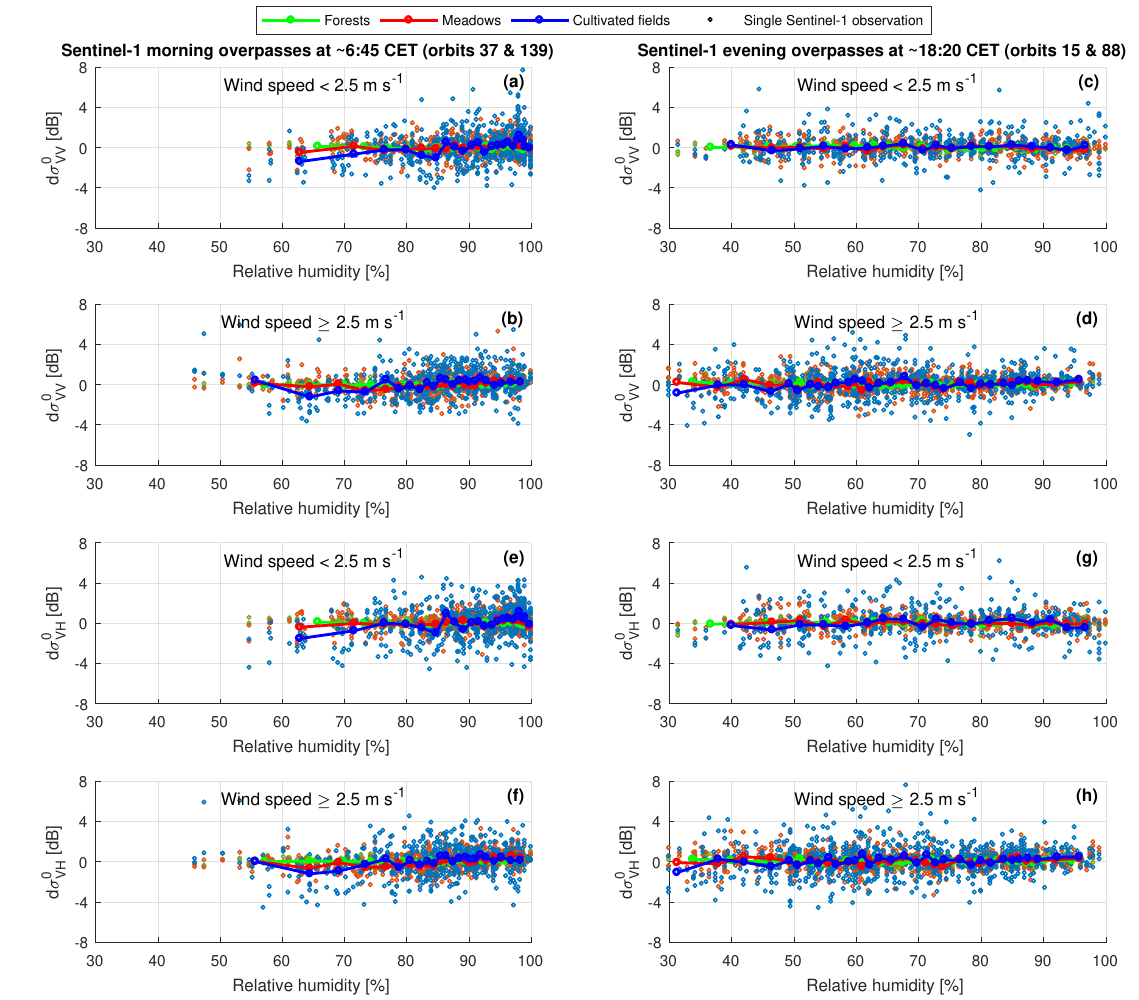
Figure 9. The effect of relative humidity on the seasonal anomalies ( d σ 0 ), for the Sentinel-1 VV σ 0 observations acquired in the morning overpasses ( a , b ) and the evening overpasses ( c , d ), and the Sentinel-1 VH σ 0 observations acquired in the morning overpasses ( e , f ) and the evening overpasses ( g , h ). The Sentinel-1 observations are shown separately for weak and strong winds (average wind speeds in the hour of the Sentinel-1 observation below and above 2.5ms −1 , see the text in the sub-figures). Each point on the lines represents a bin of 25 Sentinel-1 observations along the x-axis. The Sentinel-1 observations masked for frozen conditions or rain interception are not